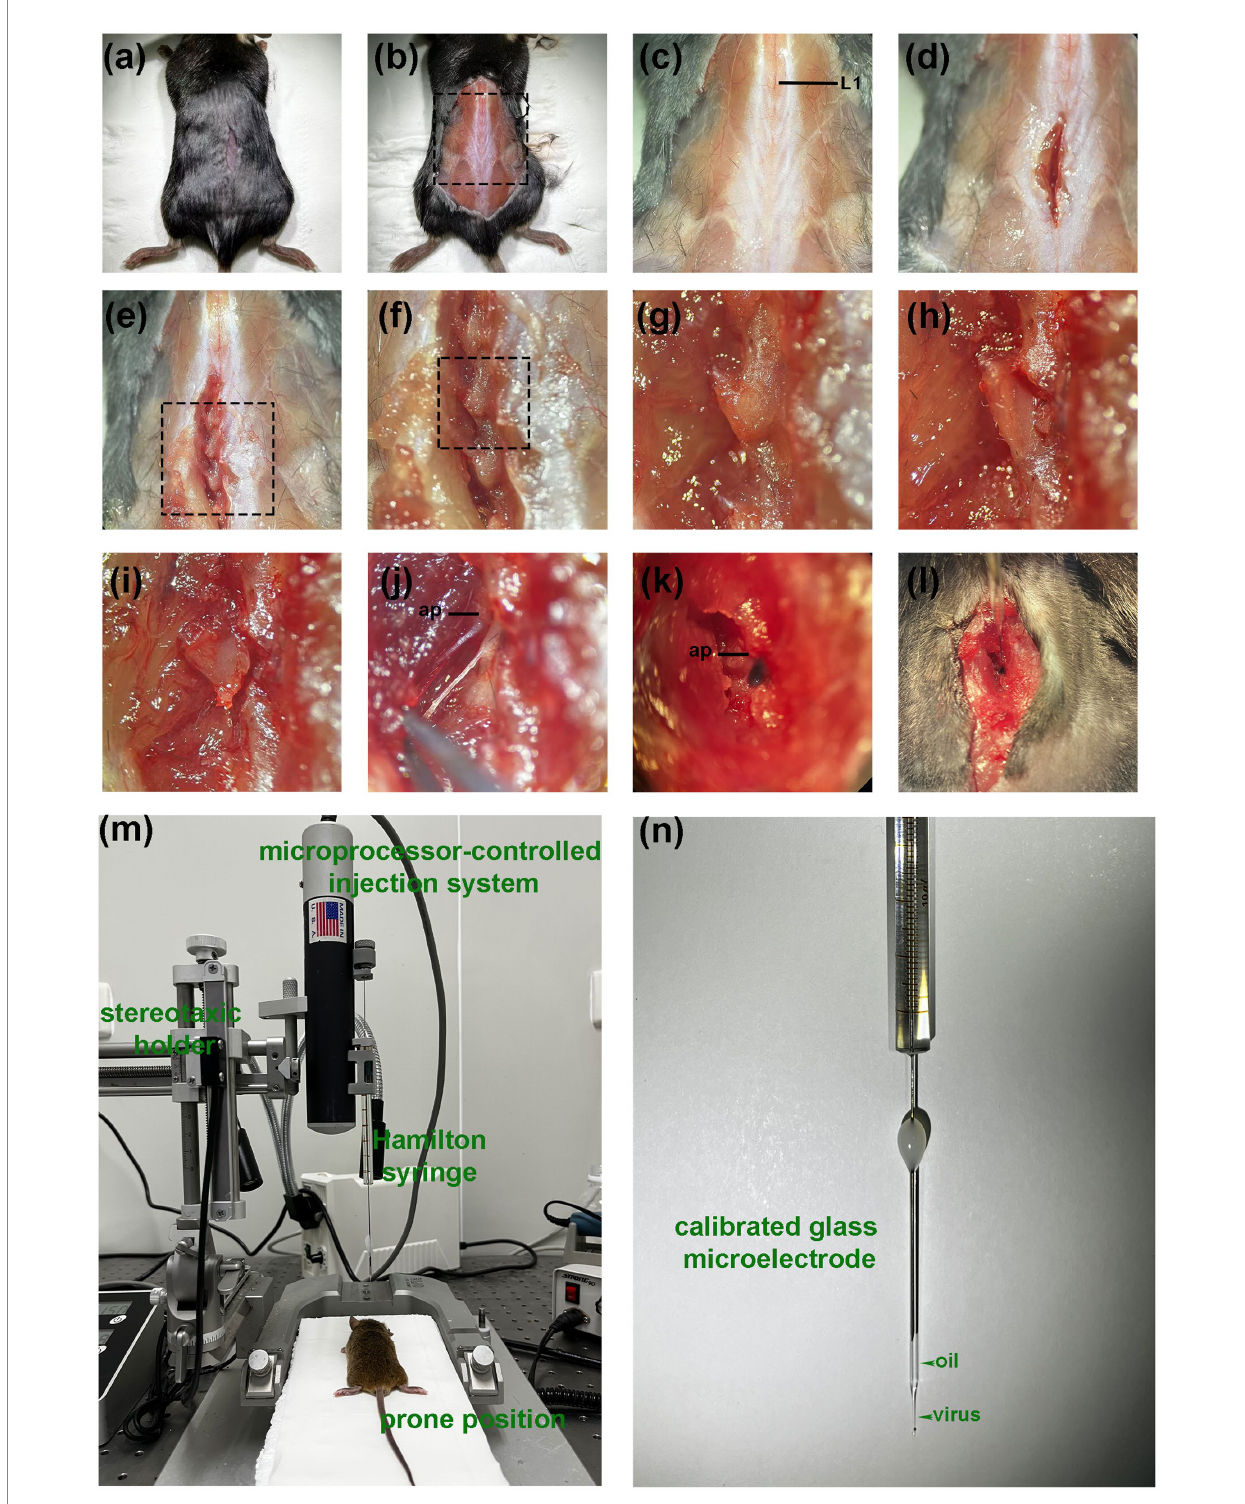
FIGURE 3 Procedure of DRG injection under direct vision. (A) After anesthesia, a small incision is made in the dorsal skin at the level superior to posterior superior iliac spine. (B) The incision is enlarged for better visualization (for display only, not part of the operation steps). (C) The first junction of the spinous process and the silvery white aponeurosis is identified as a positional marker (L1 spinous process). (D) A deep muscle incision is made along the lateral surface of the spinous process. (E–G) Expose the left intervertebral joint and the left vertebral plate. (H) Excision of the inferior articular eminence. (I) Excision of the superior articular eminence. (J) Exposure of the DRG. (The distal end is fixed with forceps because the display causes the wound to widen, resulting in distal fixation failure). (K,L) Visual field during in vivo injection. (The DRG is filled with dye). (M) Diagram of the